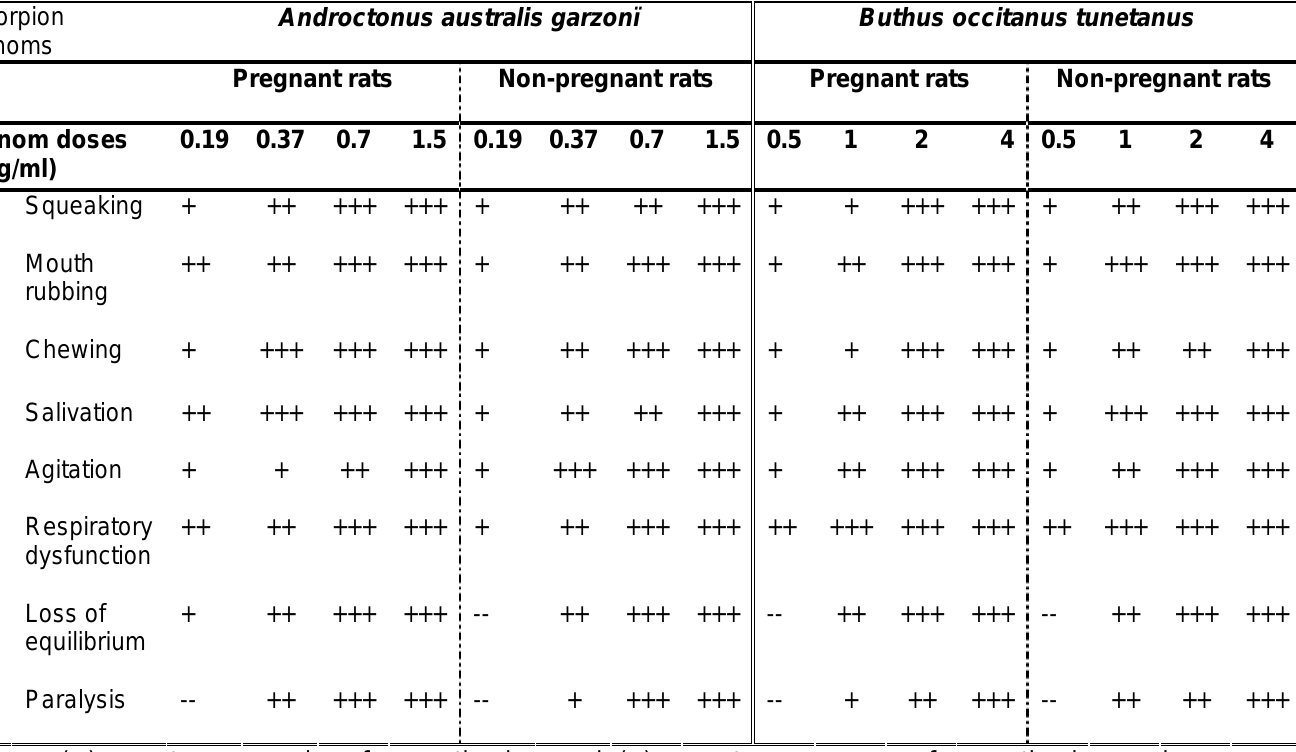
Table 2. Envenomation symptoms developed after intraperitoneal injection of crude scorpion